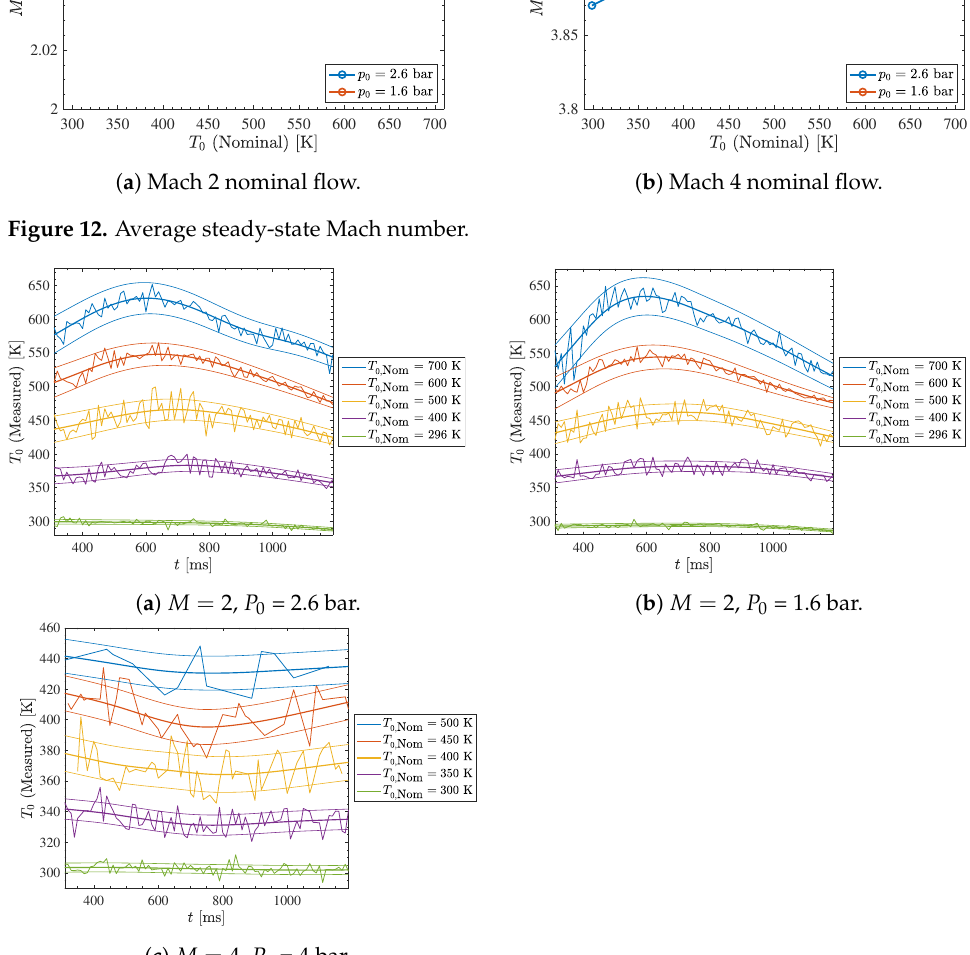
Figure 13. Results for T 0 . Curved line is a cubic smoothing spline, and error bars represent one standard